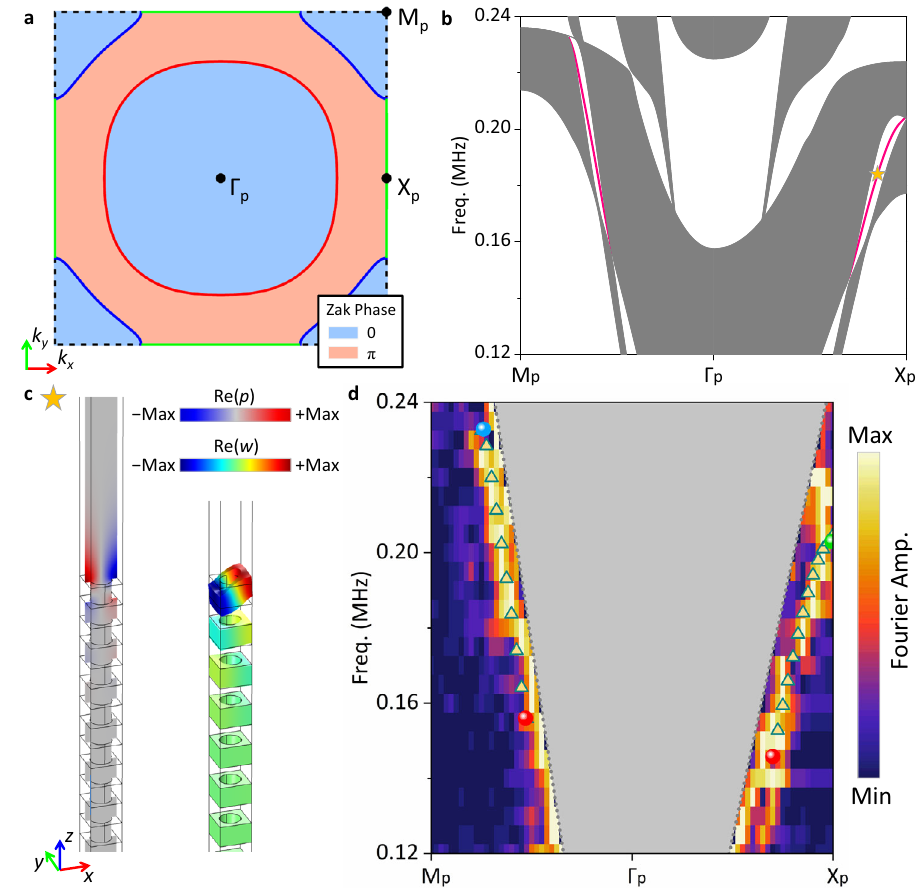
Fig. 4 | Strongly tilted drumhead surface state (DSS) between nodal rings. a Distribution of Zak phase on the surface FBZ projected along z direction. b Calculated projected band structure of a supercell terminated by x - y surface. Solid lines represent the strongly tilted DSS. Gray shaded regions denote the pro- jected bulk bands. c Calculated fi eld maps of acoustic pressure (Re( p )) and elastic